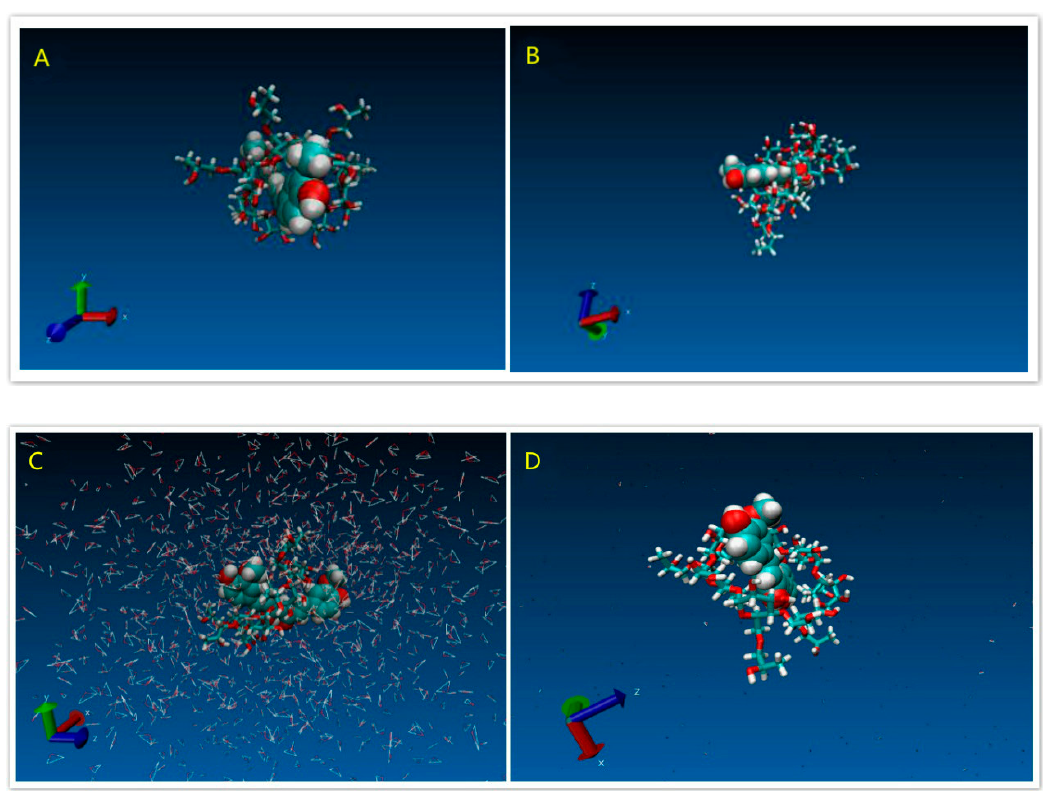
Figure 12. Snapshots of the HCD / Cur inclusion complex: ( A ) HCD / Cur initial structure system; ( B ) HCD / Cur structure after 50 ns MD; ( C ) initial structure in solvent system; and ( D ) system structure after 50 ns MD in the solvent system.